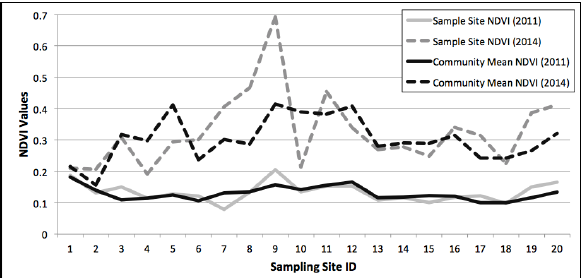
Figure 3: NDVI values of the 20 sampling locations and the NDVI means in each related mangrove community.